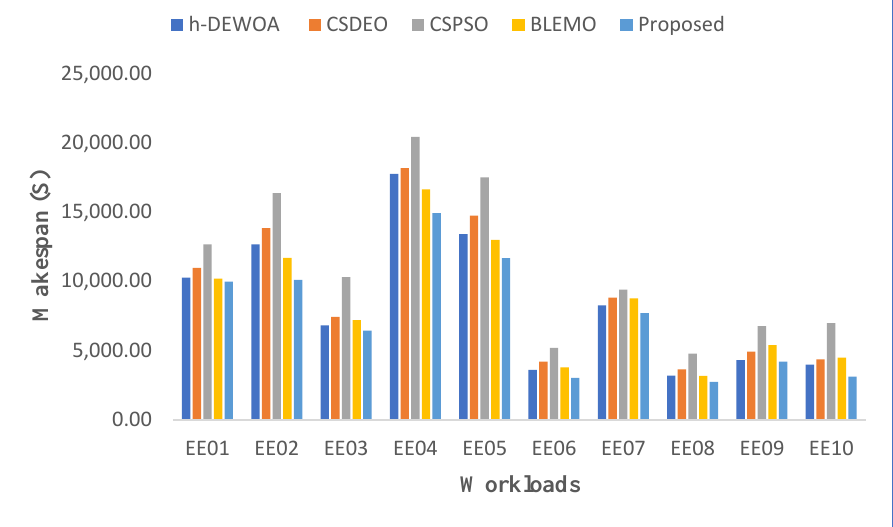
Figure 3. Graphical representation of best makespan values on CEA-Curie workloads.